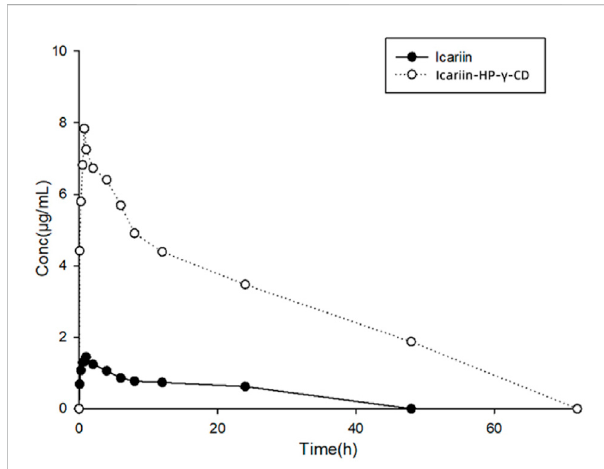
FIGURE 12 Curvesofdrugconcentrationsinplasmafromdogsadministered with icariin or its HP- γ -cyclodextrin complex.